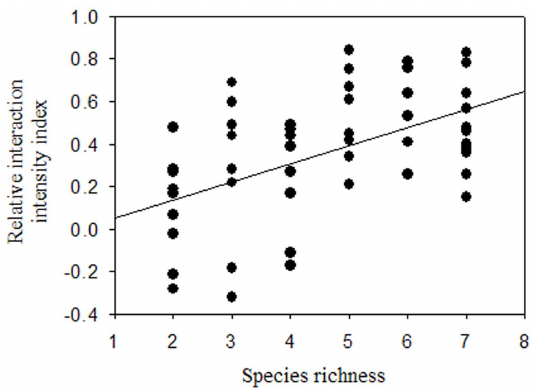
Footnotes: Species abbreviations and their corresponding full names are listed in Table